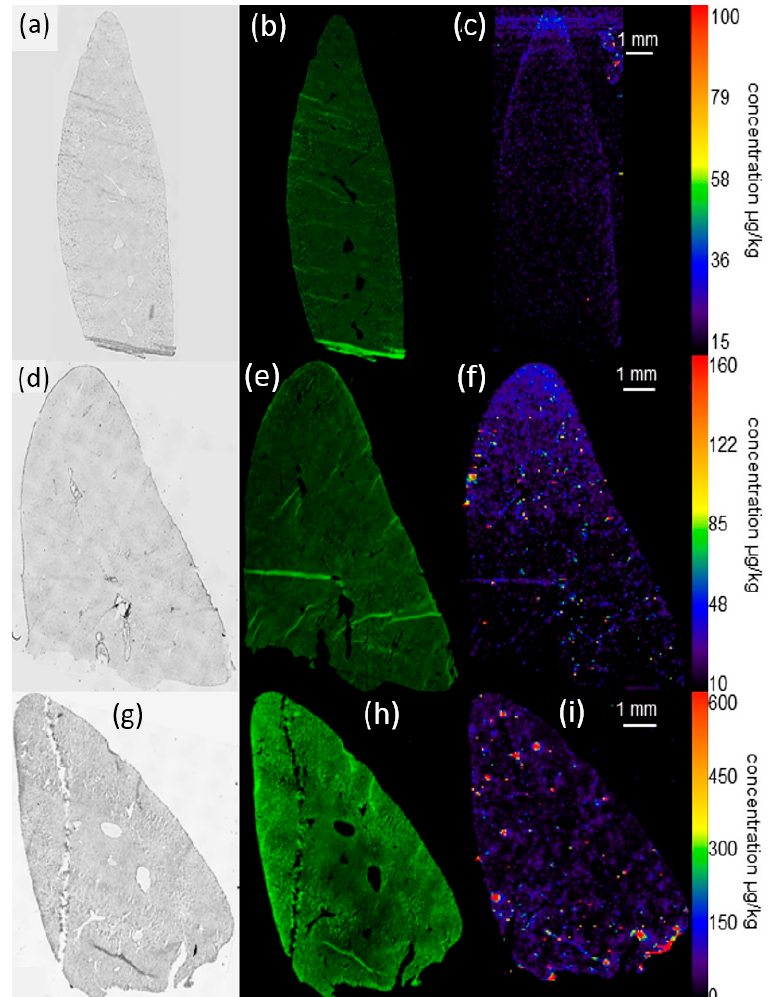
Figure 5. Distribution of silver in the liver 21 days post intratracheal instillation of Ag50-PVP into the rat lung. ( a – c ) Control animal; ( d – f ) 150 µg Ag50-PVP; ( g – i ) 300 µg Ag50-PVP. Low power micrograph ( a , d , g ), auto-fluorescence ( b , e , f ) and quantitative Ag distribution images determined by laser-ablation inductively-coupled mass spectrometry ( c , f , i ). Pseudocolor scales of the Ag concentration were adapted to organ concentration; maximum values of Ag are described in the text.